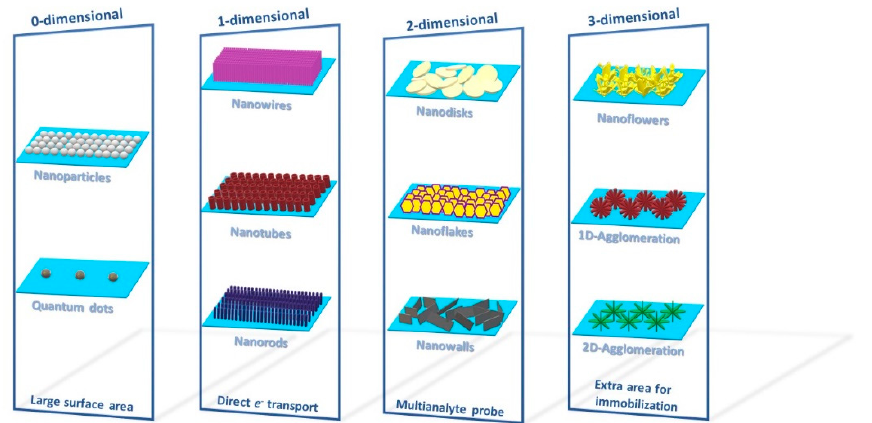
Figure 15. Four different dimensions of ZnO nanostructures with their advantages. 0D nanostructures provide large surface area. 1D nanostructures possess stable and direct electron transport. 2D nanostructures give specific planes for immobilization process for the simultaneous detection of different analytes. 3D nanostructures have extra surface area (outer and inner area) to provide more sites for immobilization.